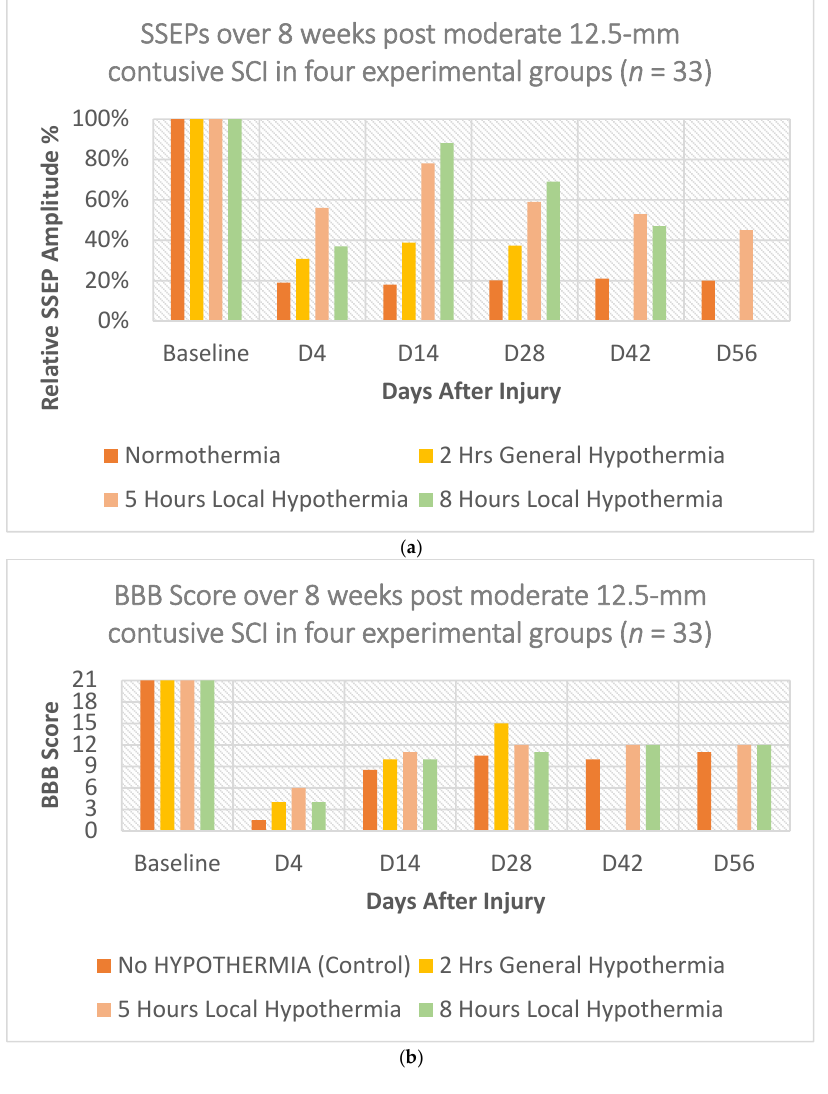
Figure 3. Shows the ( a ) SSEP results and ( b ) BBB scores of normothermia group and the 2 h general (32 °C ± 0.5 °C) as well as 5 h and 8 h local hypothermia (30 °C ± 0.5 °C) in rats with either laminectomy (no injury) or moderate T8 contusive SCI.